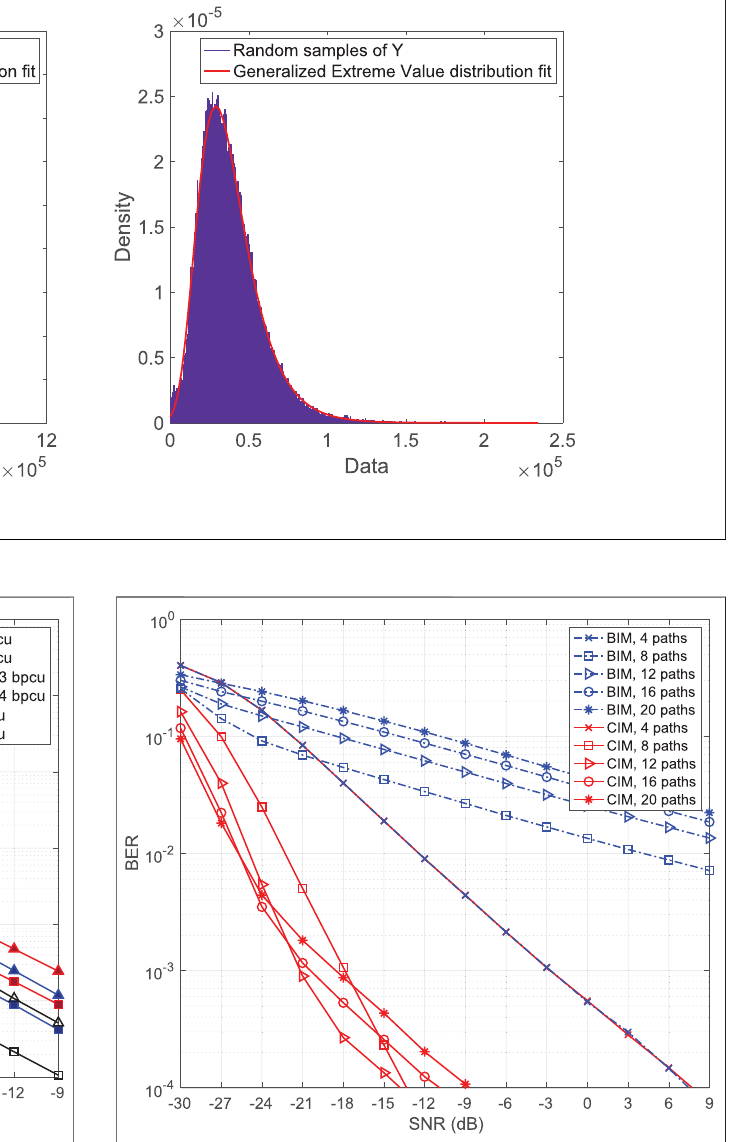
FIGURE 7 | CIM and BIM performance